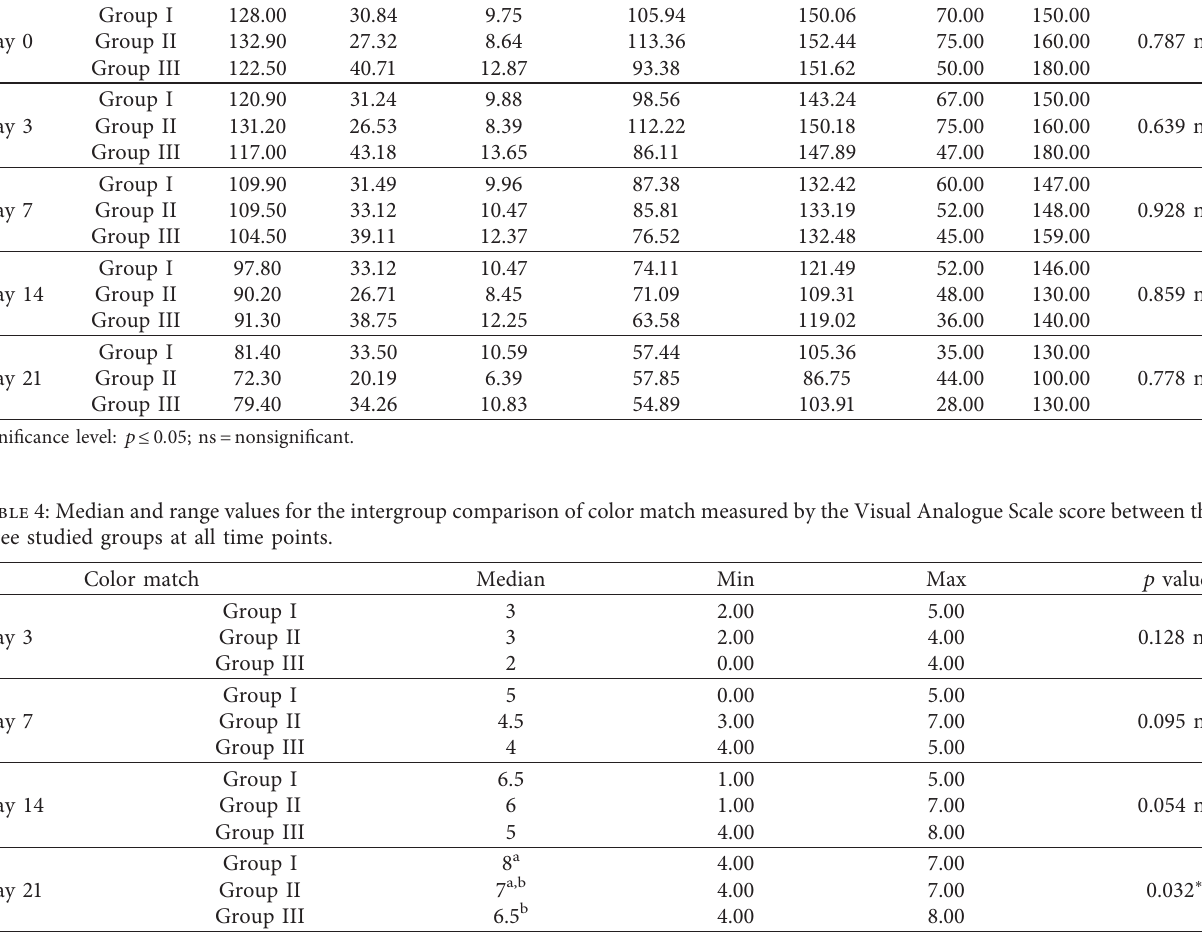
Table 3: Mean and SD values for the intergroup comparison of wound size (mm) in the three studied groups at all time points. Wound size Mean Std. dev.